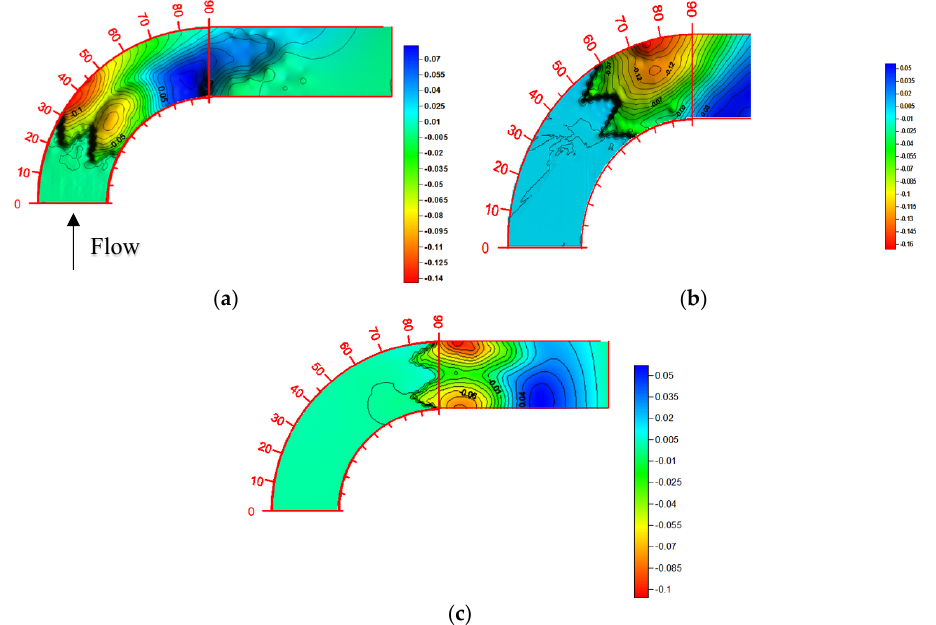
Figure 5. The topography of the bed for a Froude number value of 0.28 and W − Weir installation at 30, 60, and 90 degrees (all dimensions in meters). ( a ) Installation angle = 30 degrees. ( b ) Installation angle = 60 degrees. ( c ) Installation angle = 90 degrees. Table 2. The maximum depth of the scour holes for di ff erent Froude numbers and W − Weir instal ‐ lation at 30, 60, and 90 degrees.